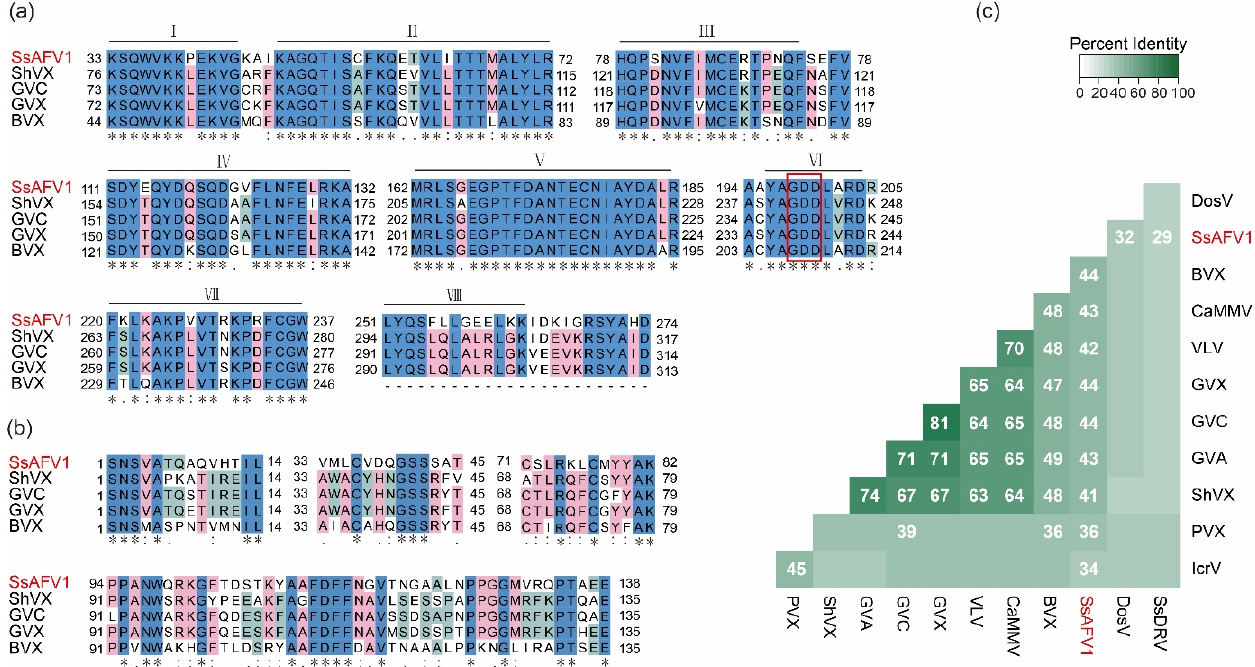
Figure 4. Multiple-alignment analysis of RdRp and CP of SsAFV1 and selected viruses. ( a ) Alignment of conserved RdRp of SsAFV1 and four selected alphaflexiviruses (Table S1). Eight conserved domains (I–VIII) among alphaflexiviruses are marked and GDD in the red rectangular box is the typical catalytic motif of positive single-RNA viral RdRp. Identical residues are indicated by asterisks and highlighted in blue. The conserved and semi-conserved amino-acid residues are indicated by colons and dots and highlighted in pink and green, respectively. ( b ) Alignment of conserved CP motifs of SsAFV1 and four selected alphaflexiviruses. Abbreviations of selected viruses are given in Table S1. ( c ) A percentage-identity matrix of viral replicase multiple-aligned via Clustal Omega 2.1 and generated by a custom R script. Abbreviations of viral names and GenBank accession numbers are listed in Table S1.